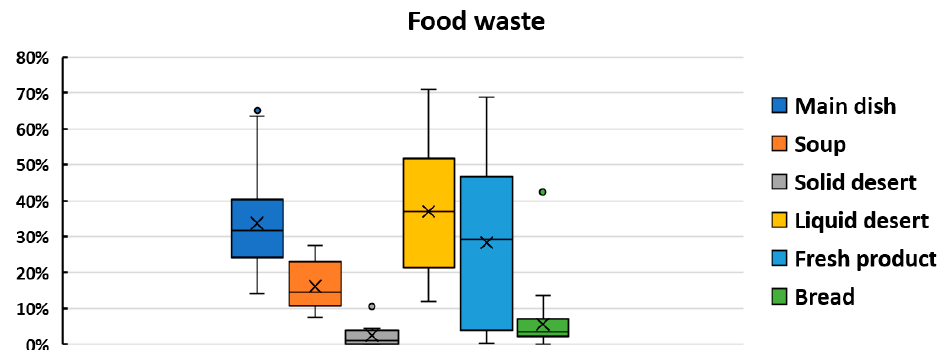
Figure 5. How frequently children are unsatisfied with a lunch.